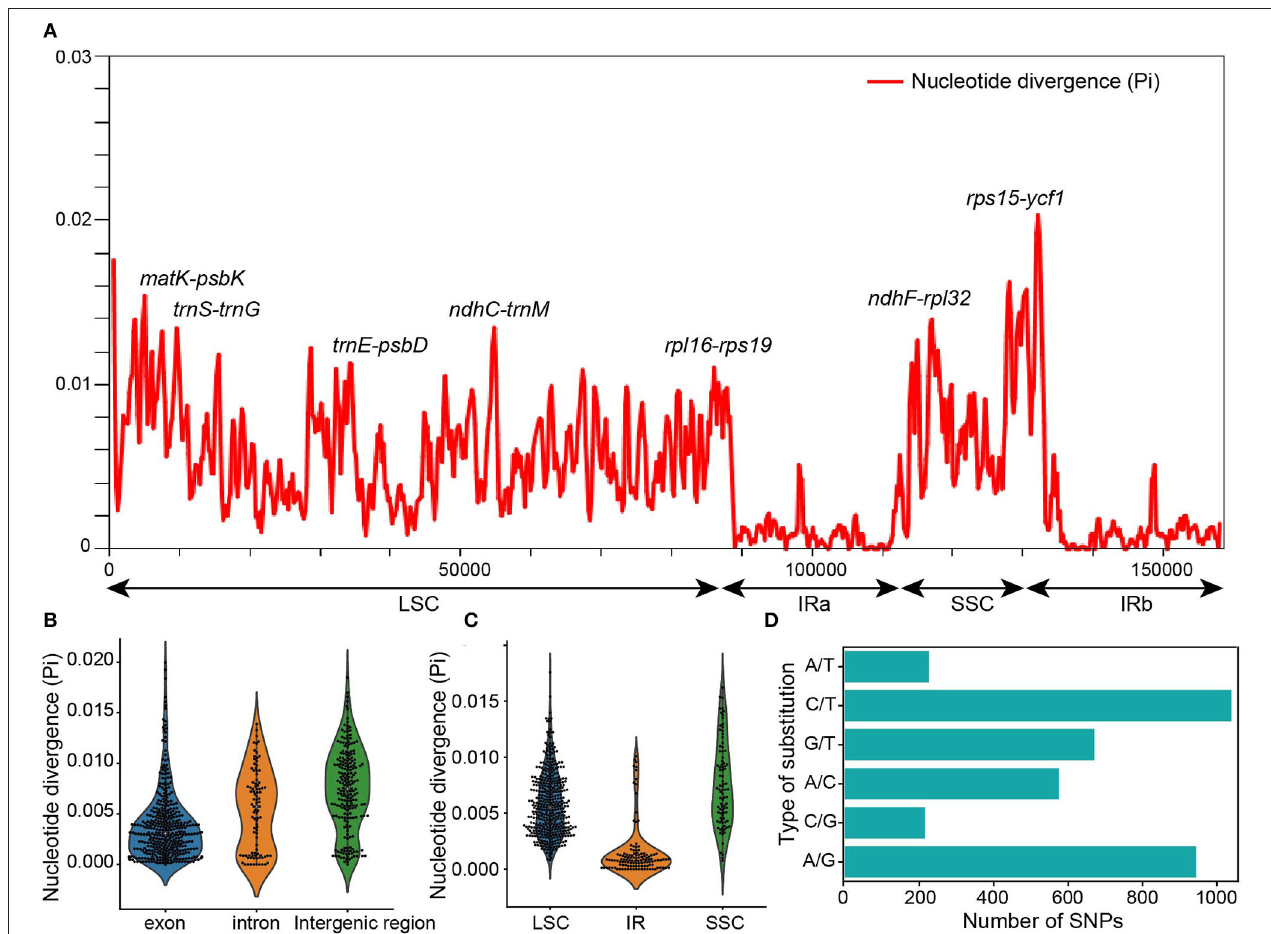
FIGURE 2 | Nucleotide divergence analysis among the chloroplast genomes of Nicotiana species. (A) Nucleotide diversity by sliding window analysis in the aligned whole chloroplast genomes. Window length: 600 bp, step size: 200 bp. (B) The nucleotide diversity values in the LSC, SSC, and IR regions of the chloroplast genomes among Nicotiana species. (C) The nucleotide diversity values in the CDS, intron, and intergenic regions of the chloroplast genomes among Nicotiana species. (D) Comparison of substitution in chloroplast genomes of Nicotiana